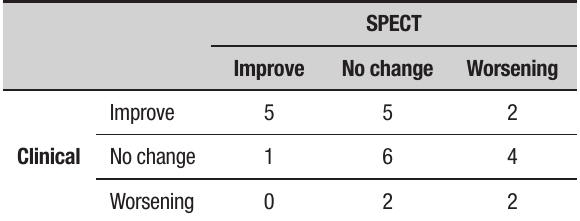
Table 1. Clinical improvement associated with SPECT